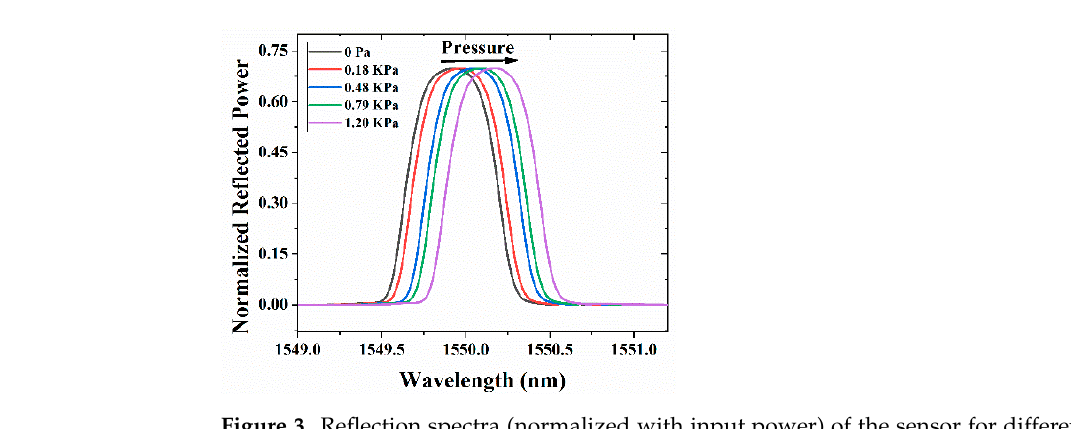
Figure 3. Reflection spectra (normalized with input power) of the sensor for different transverse pressures on the spinal cord surrogate using the optical spectrum analyzer.